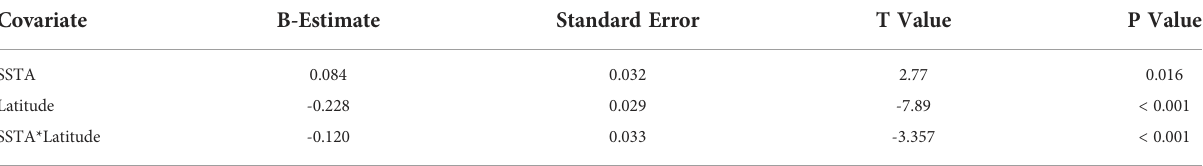
TABLE 3 Coef fi cient estimates of Sea Surface Temperature Anomalies (SSTA), latitude, and their interaction on the percent cover of Ramicrusta from a Linear Mixed Effect Model accounting for site as a random effect at DAR-WHAP sites from 2003 - 2020. Covariate B-Estimate